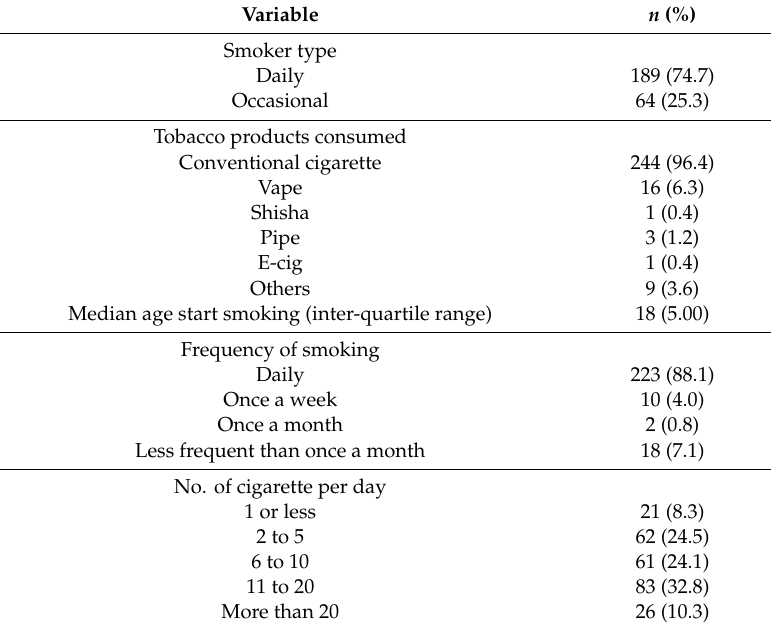
Table 4. Smoking behavior, cigarette cessation behavior, self-reported health status and co-morbidities, their awareness towards anti-smoking campaigns and the economics of smoking ( n =